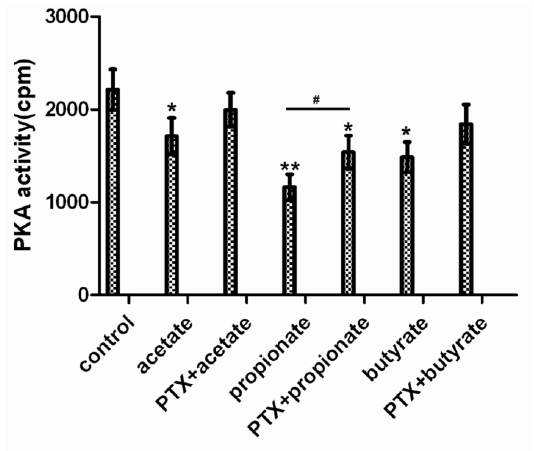
Figure 3. The effect of SCFAs on the PKA activity in DCAPCs. The cells were treated with or without prior PTX incubation (100 ng/L) for 2 h, and then stimulated with 1.0 mmol/L acetate, propionate, or butyrate for 3 h, respectively. Each treatment replicated 12 times. * p < 0.05, ** p < 0.01 vs. the control group; # p < 0.05 vs. the non PTX